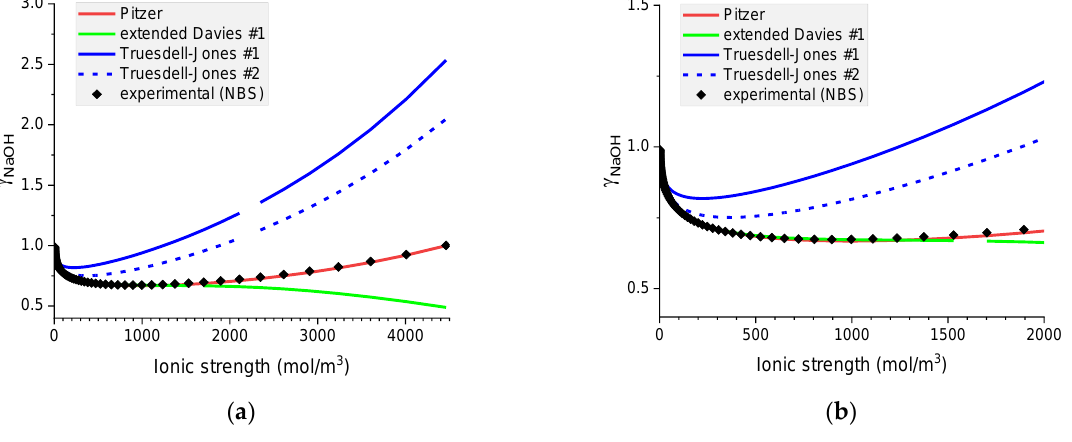
Figure 3. Molar mean ionic activity coefficients in aqueous NaOH for concentrated ( a ) and diluted ( b ) solutions. Comparison of calculated activity coefficients with experimental results (NBS) based on the Pitzer, extended Davies, and Truesdell – Jones models at 25 °C.